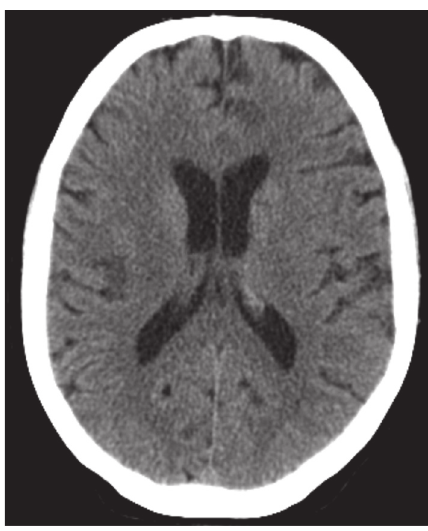
Figure 1: Ischemic stroke affecting multiple vascular